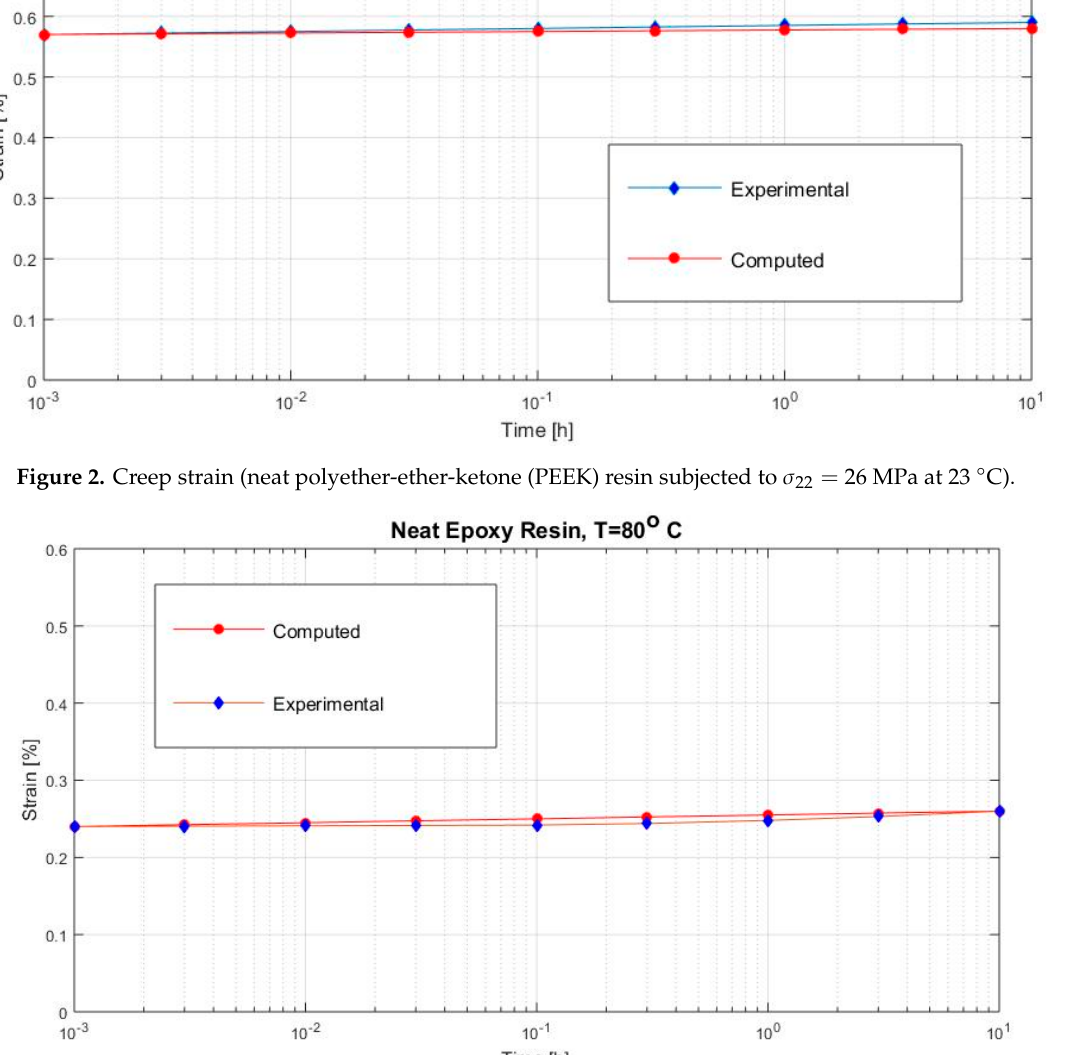
= σ 9 MPa at 80 °C). 22